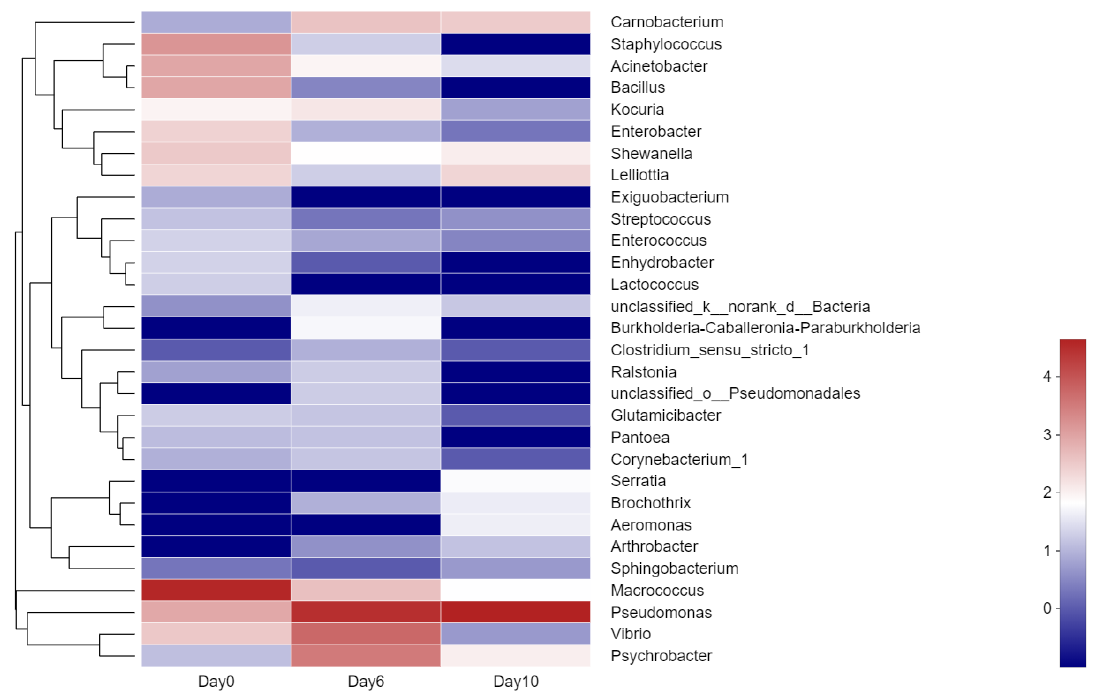
Figure 4. Community heatmap at the genus level of microbiota from hybrid grouper during storage at 4 °C. Those with the highest abundance relationships are in red, while those with the lowest abundant relationships are